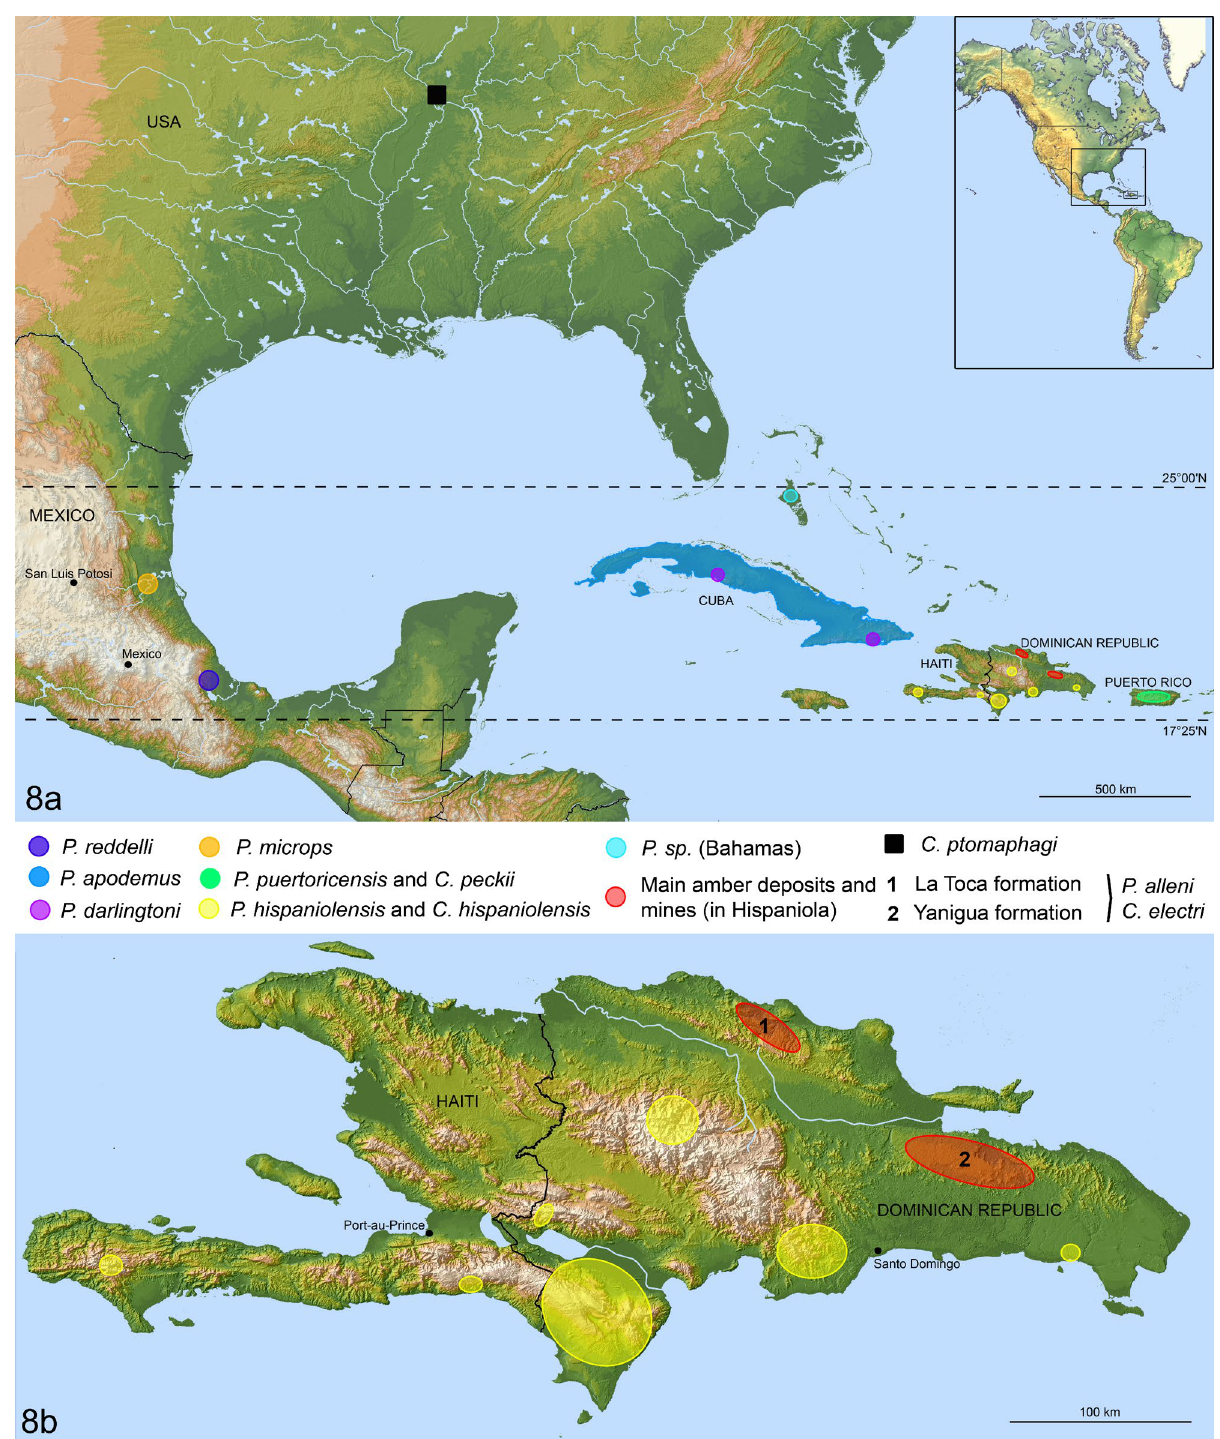
Figure 8. Distribution maps of the genera Proptomaphaginus and Columnomyces . ( a ) General map. ( b ) Detailed distribution map of Proptomaphaginus hispaniolensis , and of main amber deposits and mines in the Hispaniola island, potential locations of † Proptomaphaginus alleni with † Columnomyces electri . Geographic data sources: ASTER Digital Elevation Model V002; GTOPO30 (USGS 72 ); Global administrative area data (https ://gadm. org/); Natural Earth data (http://www.natur alear thdat a.com/). Data compiled with QGIS 2.18 (https ://www.qgis.